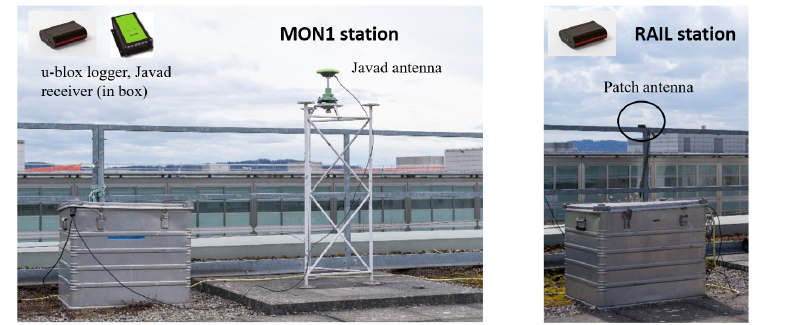
Figure 1. Session 1: experimental setup for station “MON1” for the static kinematic tests ( left -hand side) and station “RAIL” ( right -hand side), located at the roof of ETH HPV